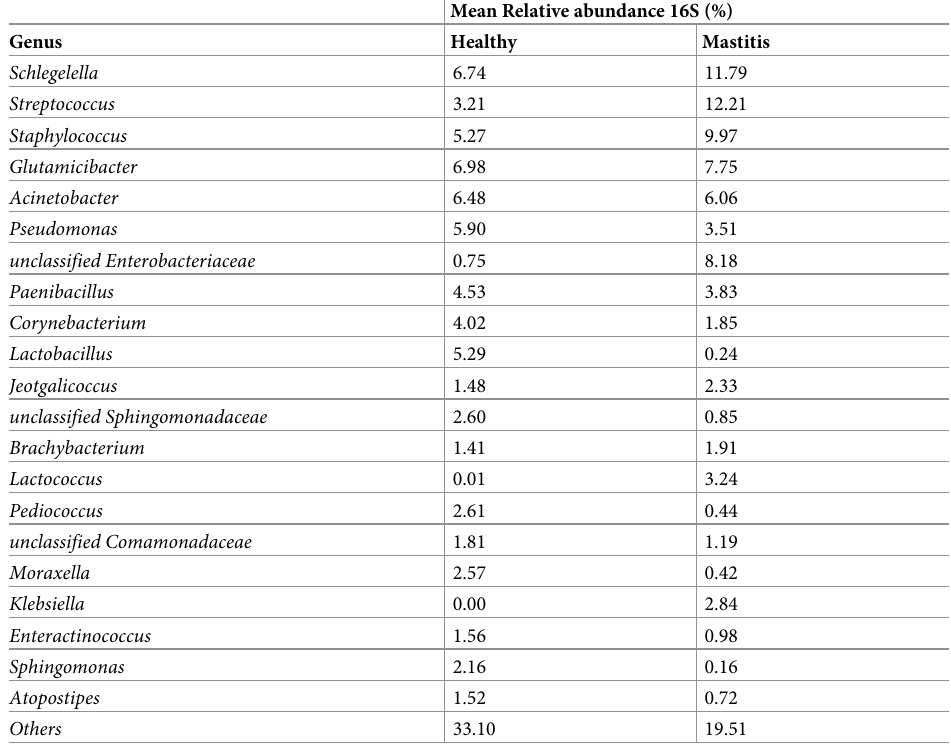
Table 2. Relative abundance of bacterial population in healthy and mastitis camel milk at genus level for 16S